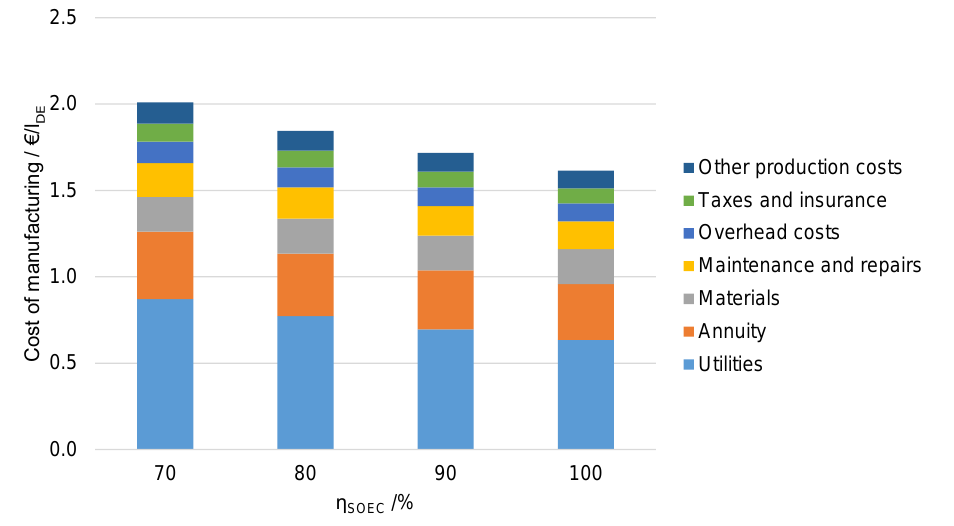
Figure 17. Product production costs depending on the electrolysis efficiency η SOEC .